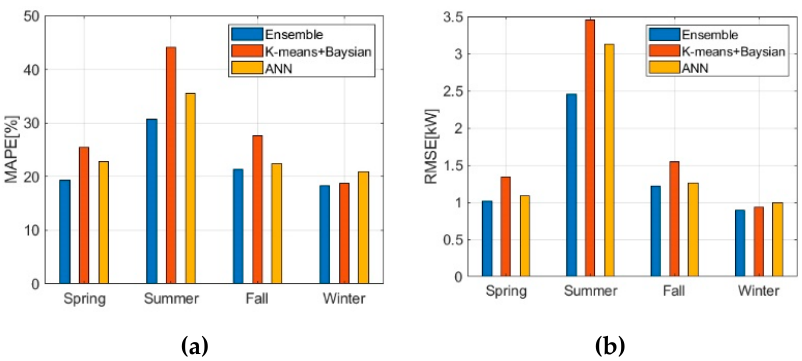
Figure 21. Testbed dataset performance evaluation of prediction models. ( a ) Performance estimation with MAPE, ( b ) Performance estimation with RMSE.